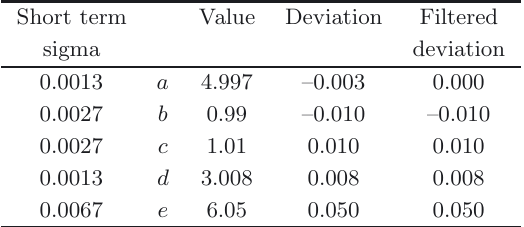
Table 3. Filtering by inertial control charts.